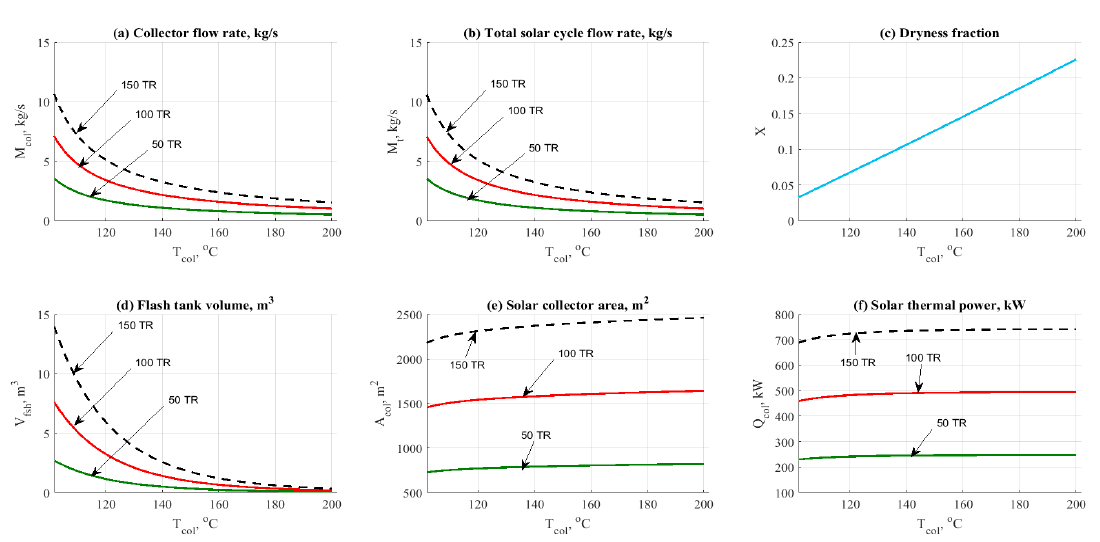
Figure 7. Data results based on the effect of ETC outlet top temperature.